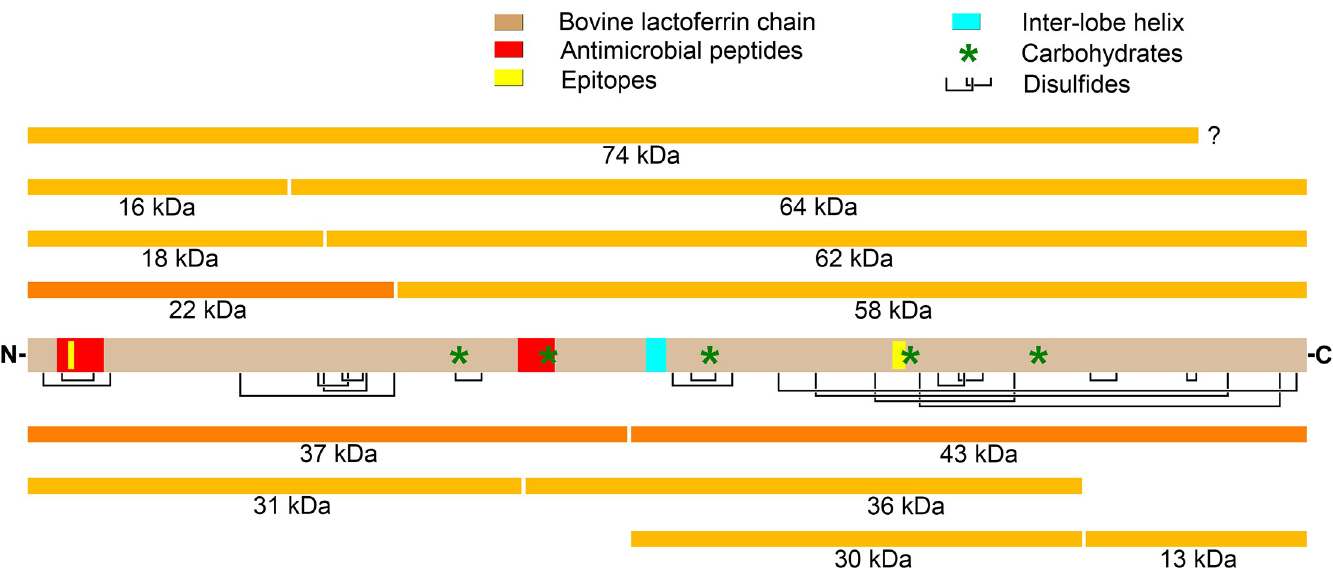
Fig 10. Fragmentation model for bLF in vaginal fluid. The central gray bar represents whole lactoferrin showing disulfide bonds (black lines), carbohydrate moieties (green asterisks), epitopes (yellow), and the antimicrobial peptides lactoferricin B (left) and lactoferrampin (middle) in red. The N- and/or C-termini of some fragments are approximate, their positions estimated only from PAGE and Western gels, which are only accurate to plus-or-minus 1–2 kDa. Others were defined precisely by mass spectroscopy as described in the text.